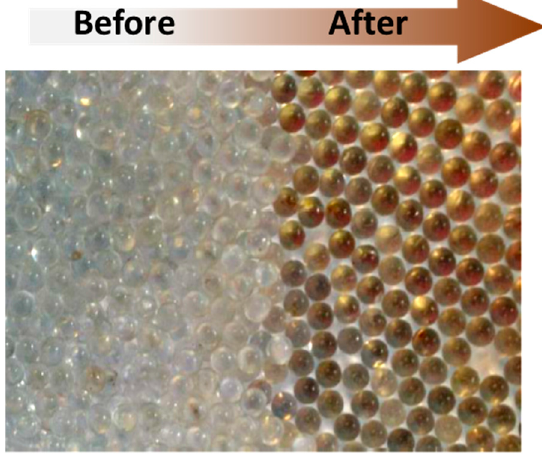
Figure 8. Image of the quartz beads before and after the WPO-O 2 process under the operating conditions of Fig.6.